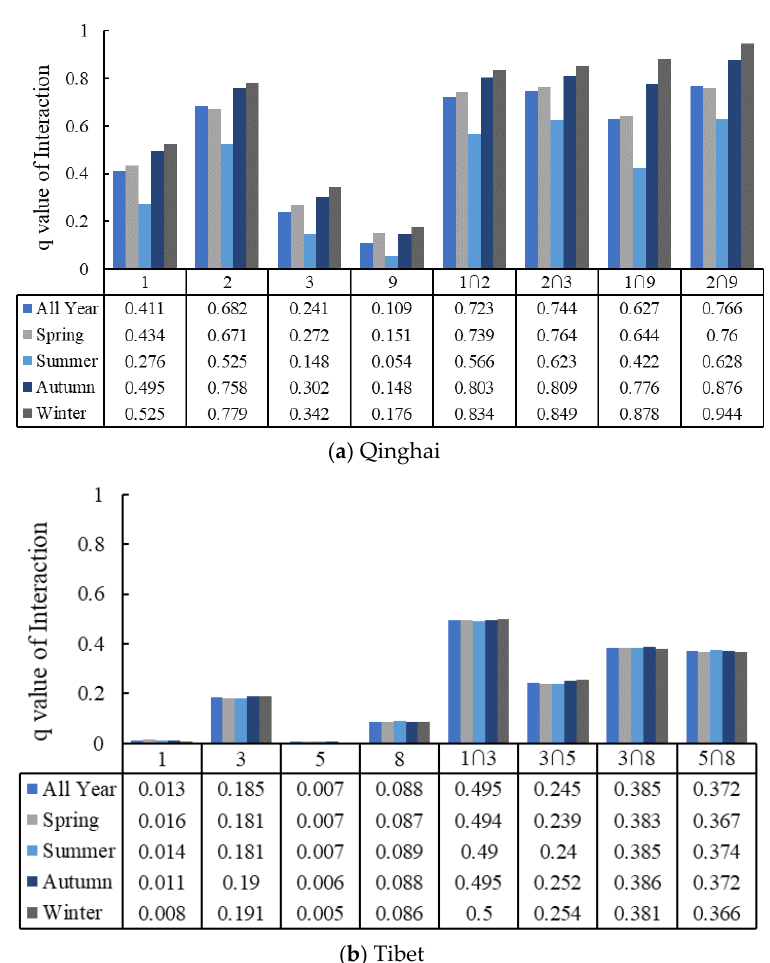
Figure 6. q -statistics of influential factor interactions in Qinghai and Tibet (1. tourist attractions; 2. hotels; 3. road network density; 5. altitude; 8. regional GDP; 9. urban area proportion).